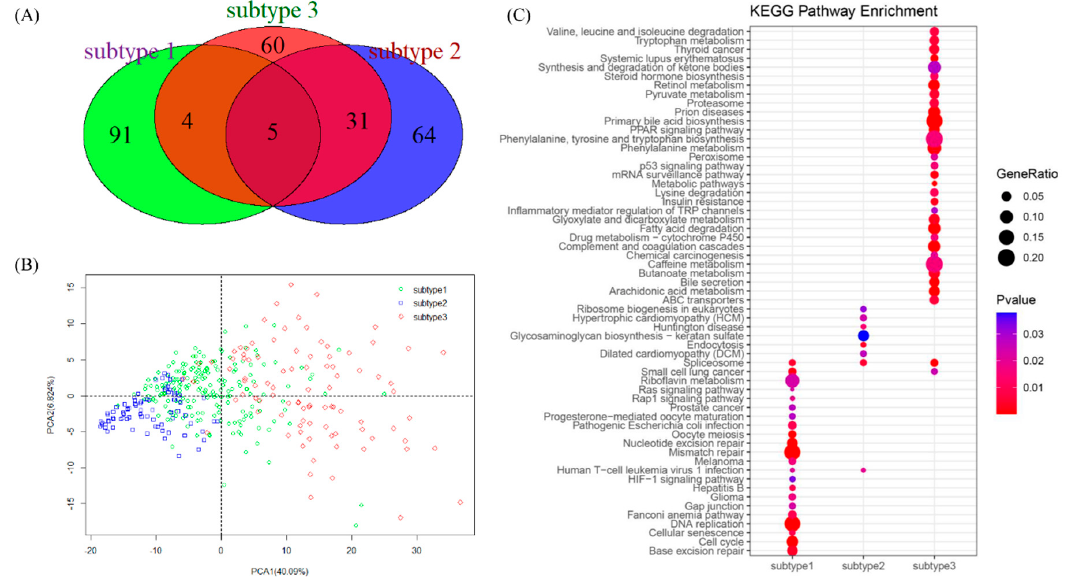
Figure 7. Three subtypes of LIHC. ( A ) Venn plot for the 300 representative genes of three subtypes. ( B ) Scatter plot showing the different spatial distribution of subtypes. ( C ) Comparison of the enriched KEGG pathway of representative genes for the three subtypes.